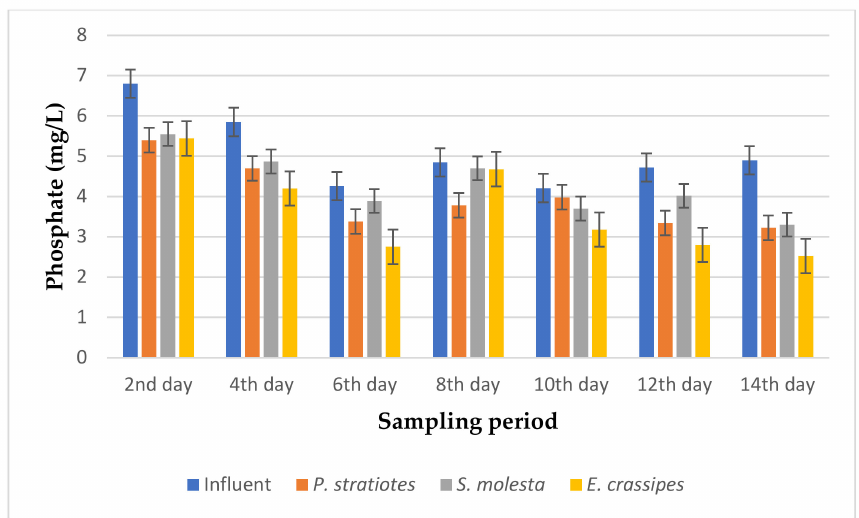
Figure 6. Bar plot of the average phosphate vs. the sampling period with a 6 h retention time.